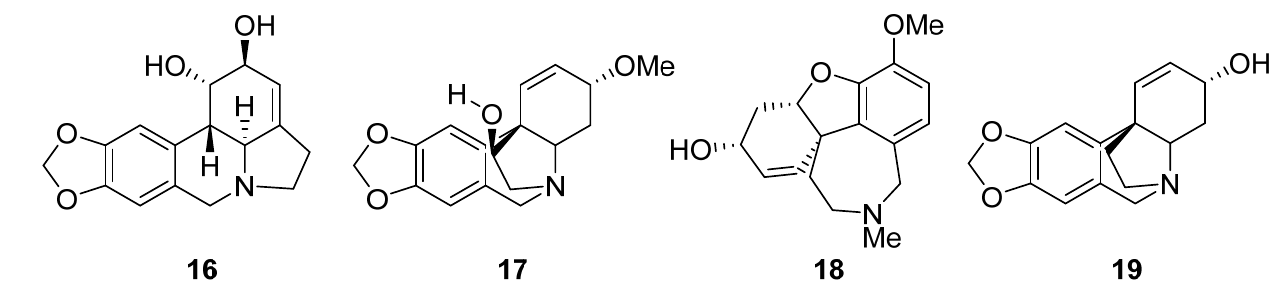
Figure 5. Chemical structures of compounds isolated from the genus Crinum . Lycorine ( 16 ), crinamine ( 17 ), galantamine ( 18 ) and crinine ( 19 ).